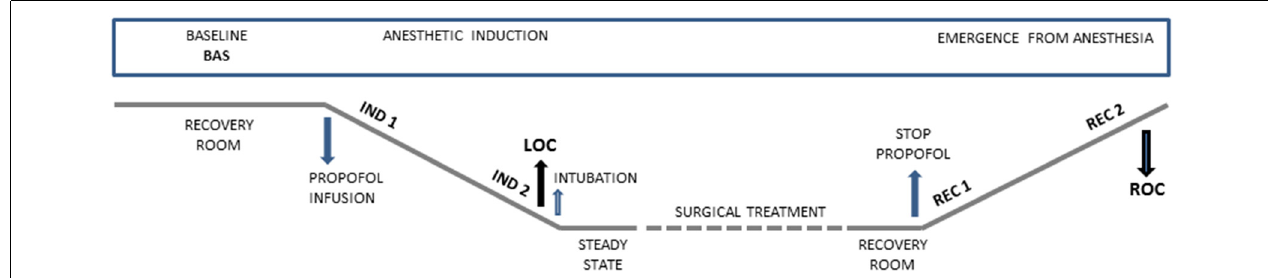
FIGURE 1 | Graphical representation showing time points of data collection during anesthetic induction and emergence from general anesthesia. Bas: Baseline, Ind1: the first period of anesthetic induction after propofol infusion, Ind2: the period before the loss of consciousness (LOC), Rec1: the first period after that the propofol infusion was stopped, Rec2: the period before the recovery of consciousness